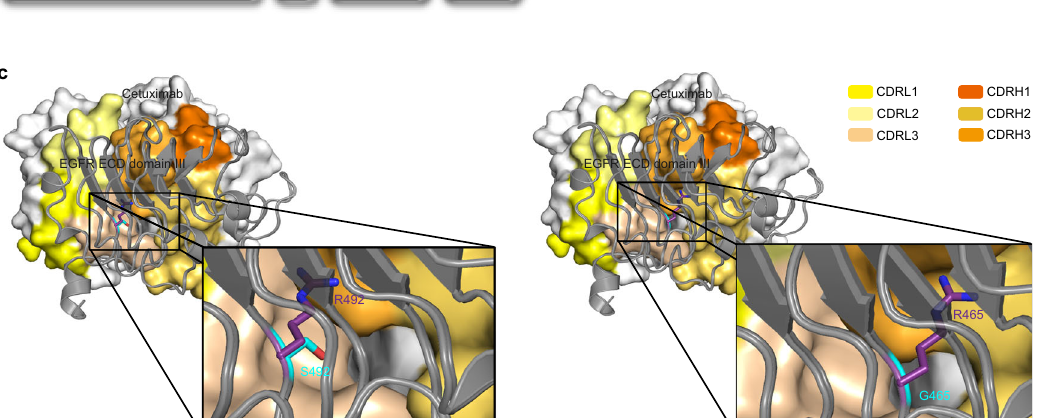
length EGFR WT or EGFR Mut were treated with cetuximab (red) or panitumumab (blue) (1, 10 and 100 nmol/L) and further fl uorescently labeled with a FITC- conjugated goat anti-human IgG (H+L) secondary antibody. Experiments were performed in triplicate. The bars indicate the mean±SD values. S492R and G465R are the two most frequent mutations, according to the literature (bottom panel). c Thereportedcrystalstructureofthewild-typeEGFRECD/cetuximabFabcomplex (PDB code: 1YY9) and the predicted structure of cetuximab in complex with EGFR S492R or EGFR G465R . Source data are provided as a Source Data fi